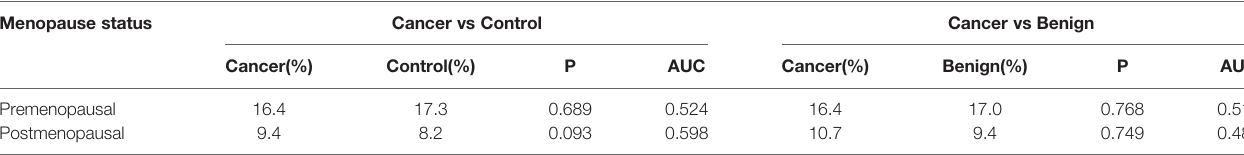
TABLE 2 | Comparison of FGT and its AUC among cancer vs control and cancer vs benign. Menopause status